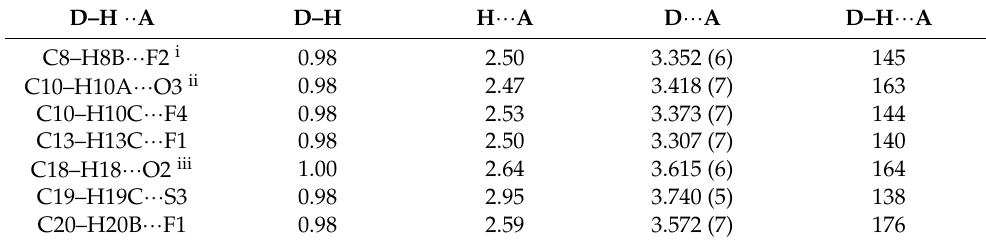
Table 4. Hydrogen-bond geometry (Å, ◦ ) for ( 2 ).